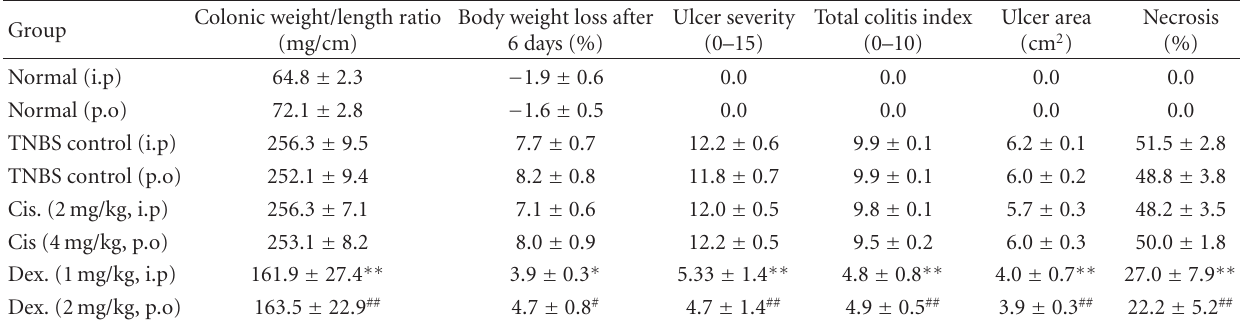
Table 2: E ff ect of cisapride (2mg/kg, i.p; 4mg/kg, p.o: daily) on macroscopic and histopathological parameters of the rat colon 6 days after induction of colitis with TNBS (50mg/kg).